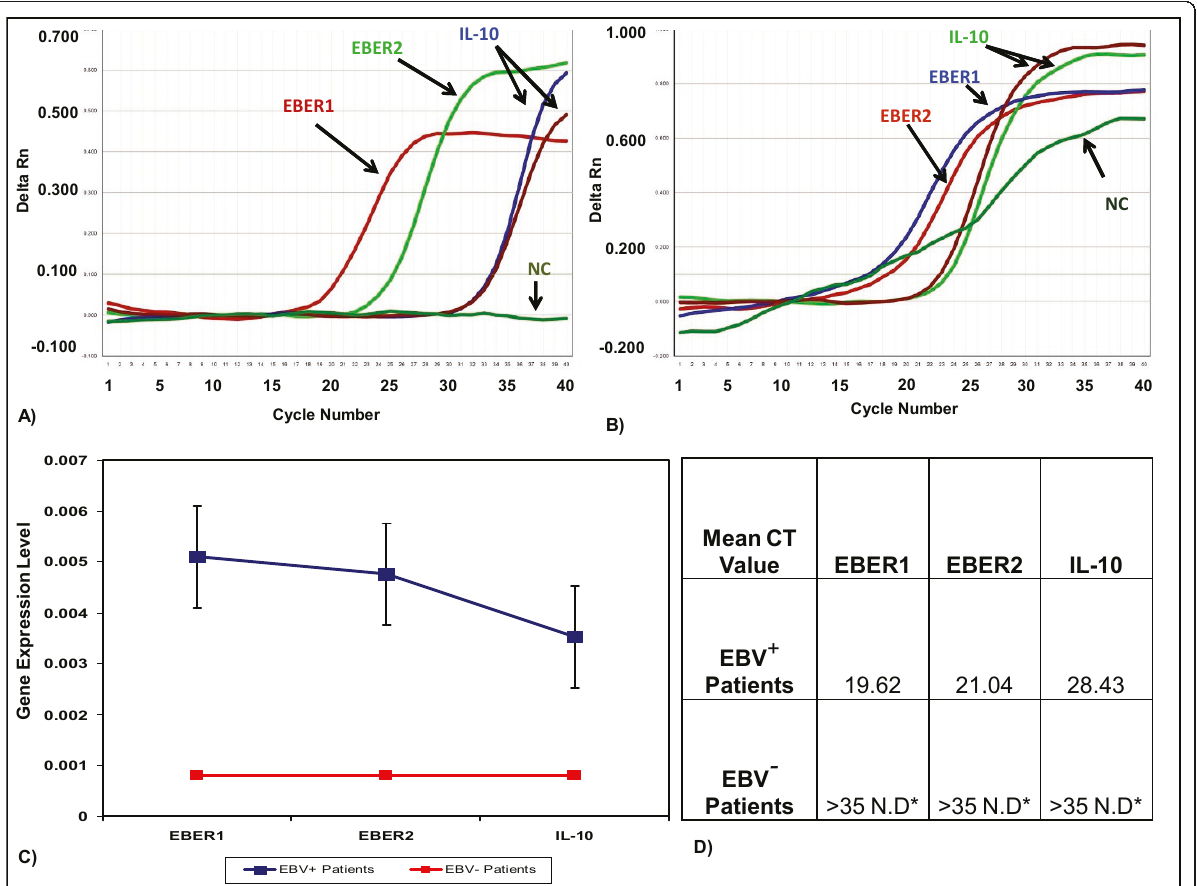
Figure 5 qRT-PCR Data analysis : Delta Rn vs Cycle (A, B): Real-time PCR amplification plot showing EBER1, EBER2 and IL-10 targets in EBV + (positive) tumor sample in comparison with EBV Negative control sample analyzed at 0.1 threshold. Successful amplifications are shown, with absence of amplification of mismatched templates. (C) Relative Expression rate of EBER1, EBER2 and IL-10 were calculated by dividing the total threshold (0.10) with mean CT value of each sample.(D) Grid representation of specificity showing mean CT values for on-target cDNA amplification for all EBV + (positive) specimens. Note the absence of nonspecific amplification. N.D*= Not